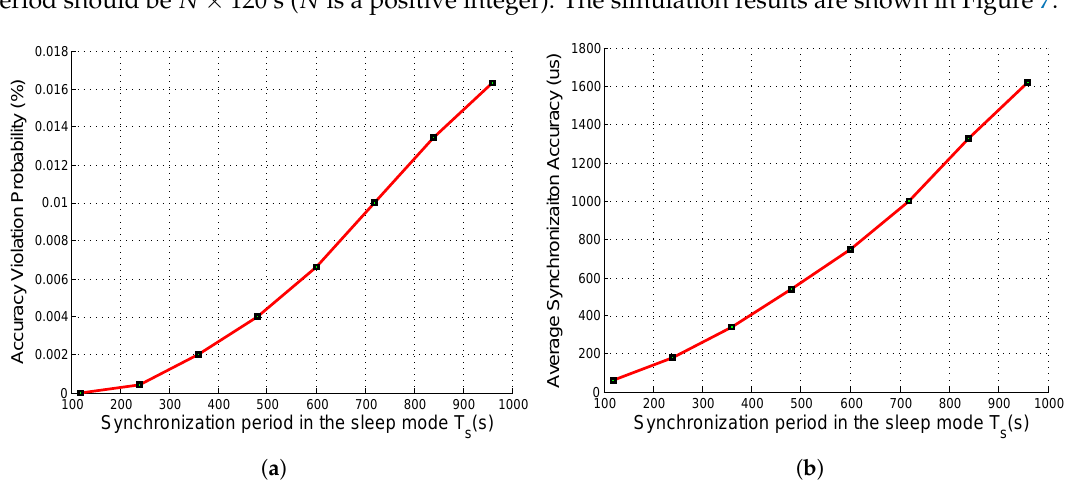
Figure 7. Synchronization metrics under different synchronization periods in the sleep mode: ( a ) accuracy violation probability; ( b ) average synchronization